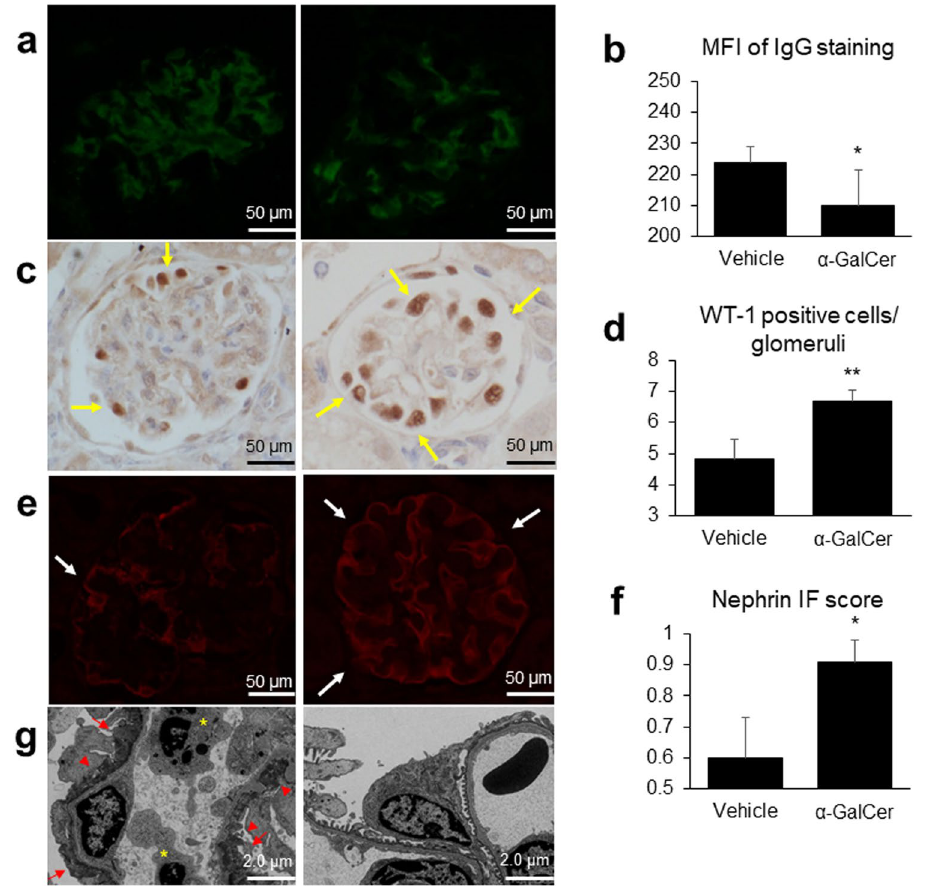
Figure 4. Alpha-galactosylceramide ( α -GalCer) treatment decreases the deposition of glomerular immune complexes and ameliorates podocyte injury. Representative images of ( a ) immunofluorescence (IF) IgG staining, ( c ) immunoperoxidase WT-1 staining, and ( e ) IF nephrin staining of kidney slices in the vehicle (left) and α -GalCer (right) groups. In ( c ) and ( e ), arrows indicate positively stained cells or areas. ( b ) MFI (mean fluorescence intensity) of IgG staining, ( d ) WT-1 positive cells/glomeruli, and ( f ) semiquantitative nephrin IF score in each group (vehicle group; n = 5, α -GalCer group; n = 7). * p < 0.05, ** p < 0.01 compared with the vehicle group. ( g ) Representative electron microscopy photomicrographs of kidney slices in the vehicle (left) and α -GalCer (right) groups. Widespread effacement of podocyte foot processes (red arrows) and electron dense immune deposits (red arrowheads) are shown in the vehicle group. Endocapillary infiltration of inflammatory cells was also observed (yellow